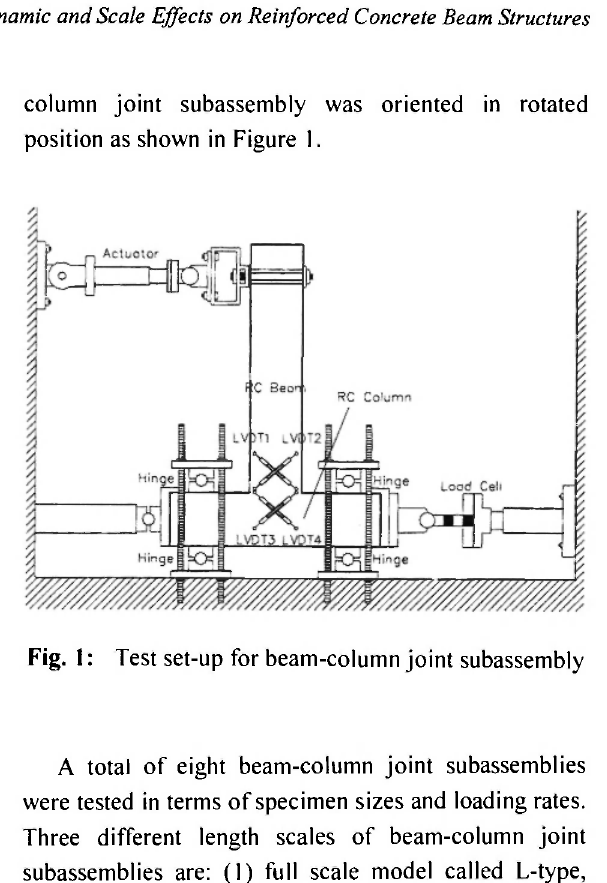
A total of eight beam-column joint subassemblies were tested in terms of specimen sizes and loading rates. Three different length scales of beam-column joint subassemblies are: (1) full scale model called L-type, (2) one-half scale model called M-type, and (3) one- quarter scale model called S-type. Static loading and dynamic loading rates ranging from 0.0025Hz to 5.0Hz were applied to each different size of specimens. The